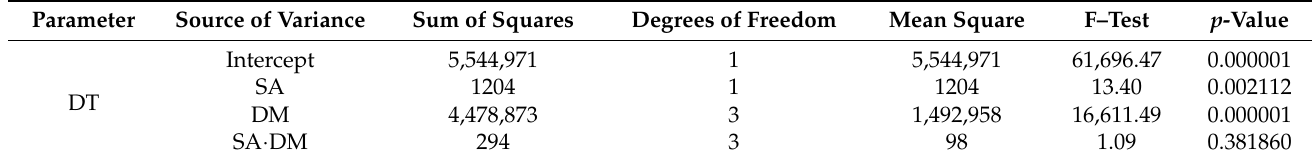
Table 1. The analysis of variance for the drying time of leek.